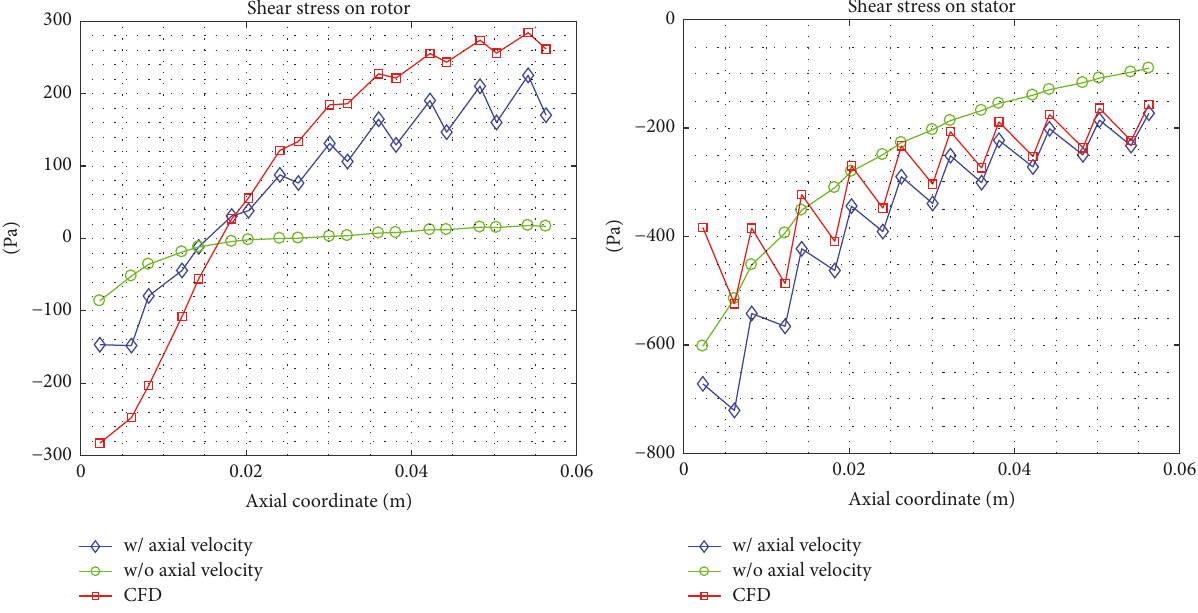
Figure 19: Rotor and stator shear stresses as a function of the axial coordinate for case 1 shown in Table 2. The CFD shear stresses are averaged along the length of each cavity to be compared with the bulk-flow